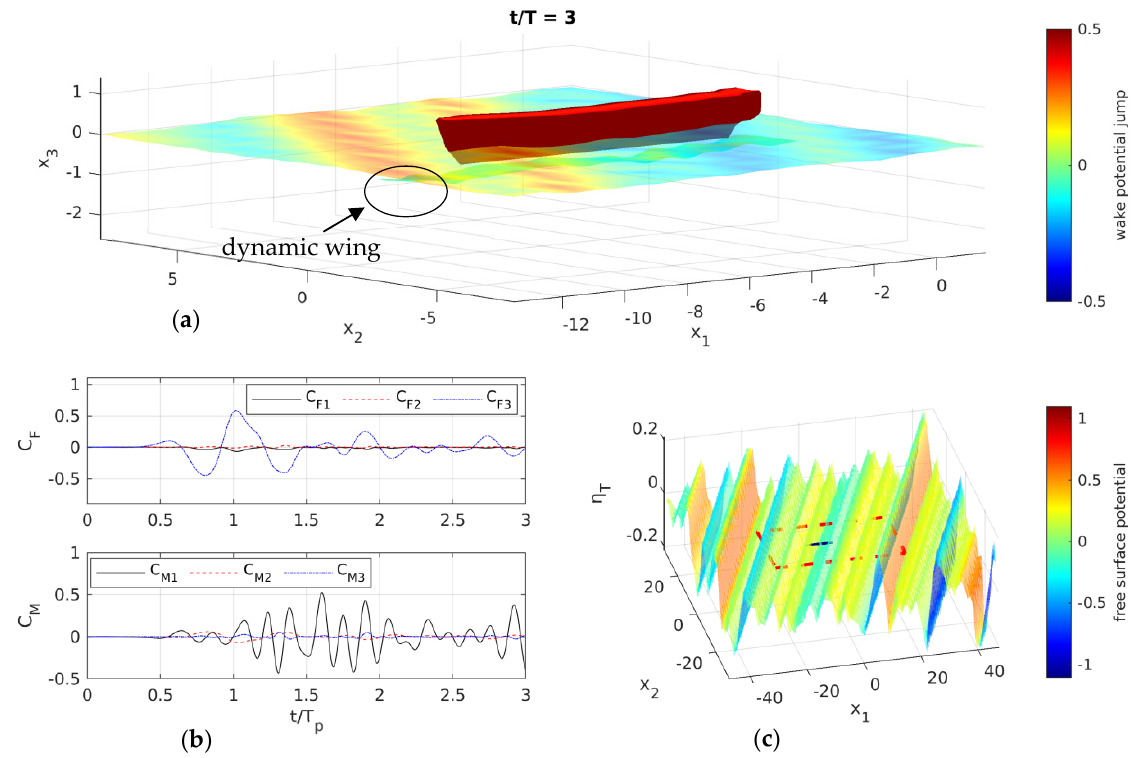
Figure 17. BEM simulation of the ferry and the foil in quartering seas ( β = 150 ◦ ): ( a ) total free-surface elevation and potential (denoted with colors), interaction with the foil wake located on the ship bow; ( b ) time evolution of forces and moments acting on the foil; ( c ) total free-surface elevation and potential (denoted with colors) all over the computational domain.